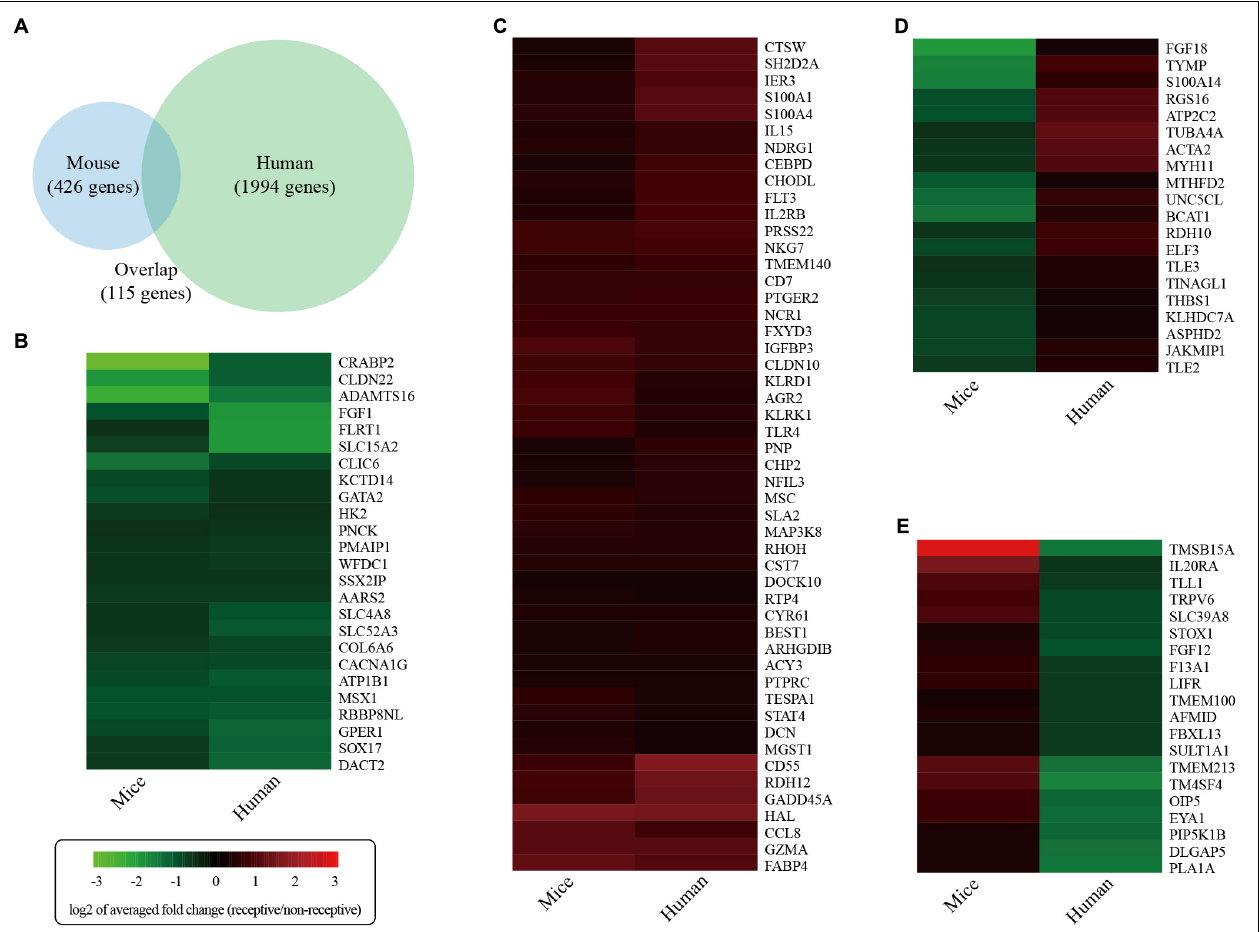
FIGURE 7 | Global comparison of the gene expression changes associated with endometrial receptivity in mice against humans. (A) Venn diagram showing the overlap of differentially expressed genes between mice and humans. (B) Consistently down-regulated genes. (C) Consistently up-regulated genes. (D) Inconsistently expressed genes that were down-regulated in mice but up-regulated in humans. (E) Inconsistently expressed genes that were up-regulated in mice but down-regulated in humans. Heatmaps were draw according to log2 of averaged fold change